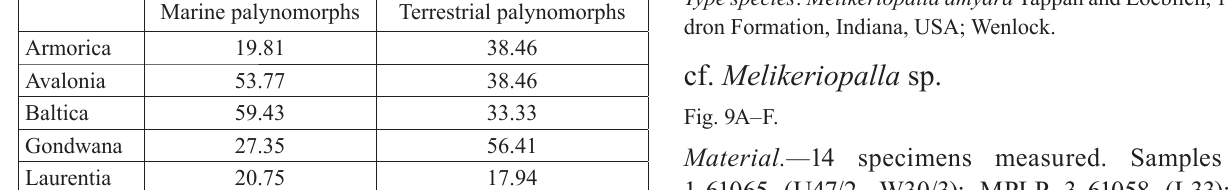
Material.— 14 specimens measured. Samples MPLP